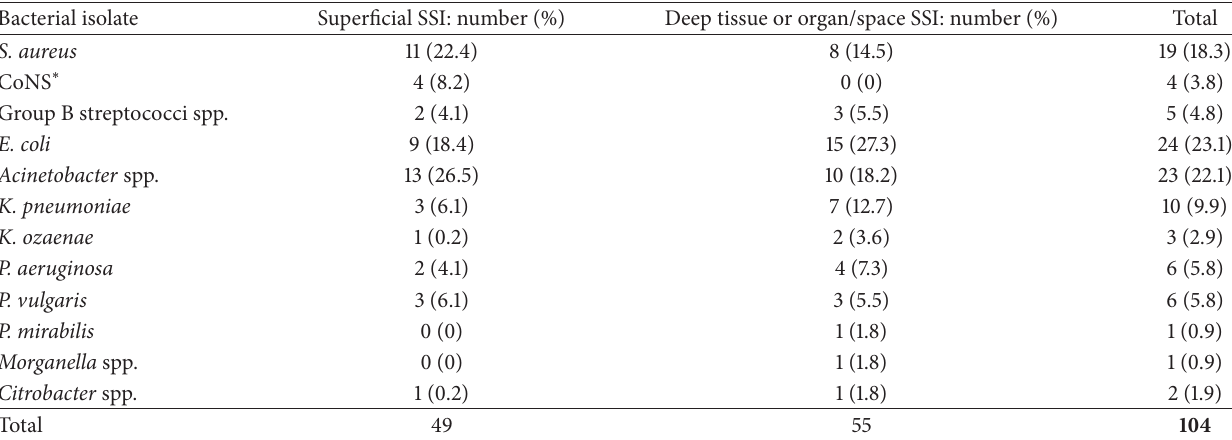
Table 3: Bacterial distribution based on SSI class.